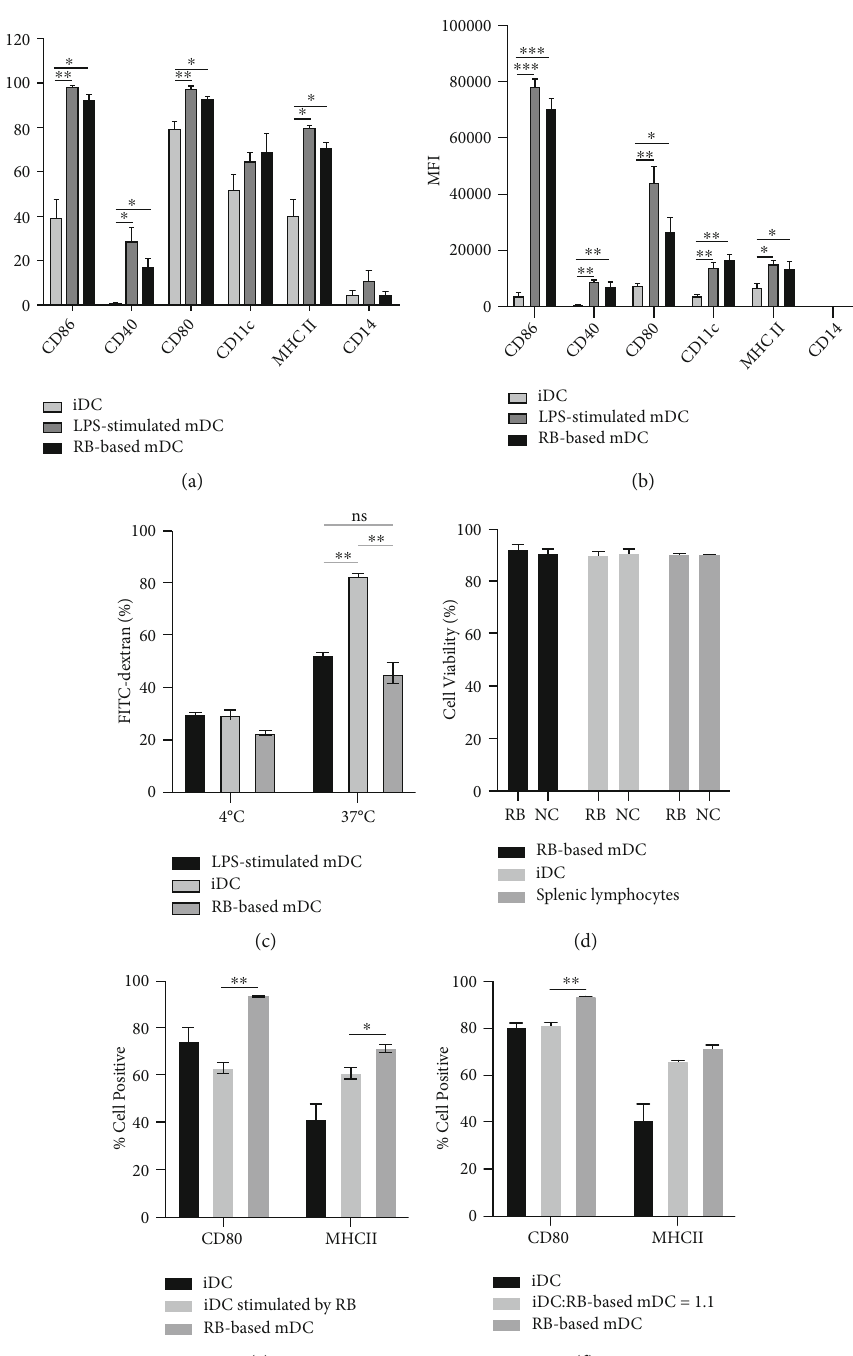
Figure 4: RB-treated LLCs induced the mature DC phenotype. The percentage of positive cells was shown according to the FMO control. On day 6, iDCs were collected and cultured with RB-treated LLCs for 69 h. The results are shown as “ RB-based mDC. ” As a positive control, iDCs were stimulated with LPS for 24 h. The results are shown as “ LPS-stimulated mDC. ” And iDCs without stimulation were used as negative control. (a, b) The percentage and the mean fl uorescence intensity (MFI) of cells that stained positive for the cell surface markers of the mature DC phenotype. The data are representative of 8 experiments. The assay was carried out in triplicate and repeated three times. (c) RB-based mDCs or LPS-stimulated mDCs signi fi cantly reduced FITC-dextran uptake compared with iDCs. (d) iDCs, RB-based mDCs, and splenic lymphocytes were treated with 1 mM RB for 24 h. Cells were cultured in medium without RB as a negative control (referred as “ NC ” ), and then, the cells were quanti fi ed using Vi-cell XR. (e, f) iDCs stimulated by RB alone (e) or RB-based mDCs (f) did not undergo maturation. The data shown are mean ± SD from representative of three independent experiments. Signi fi cance between samples was calculated by Student ’ s t - test (d) and one-way ANOVA (a – c, e, f) (ns indicates no statistical signi fi cance, ∗ P < 0 : 05 , ∗∗ P < 0 : 01 , ∗∗∗ P < 0 : 001 , ∗∗∗∗ P < 0 : 0001